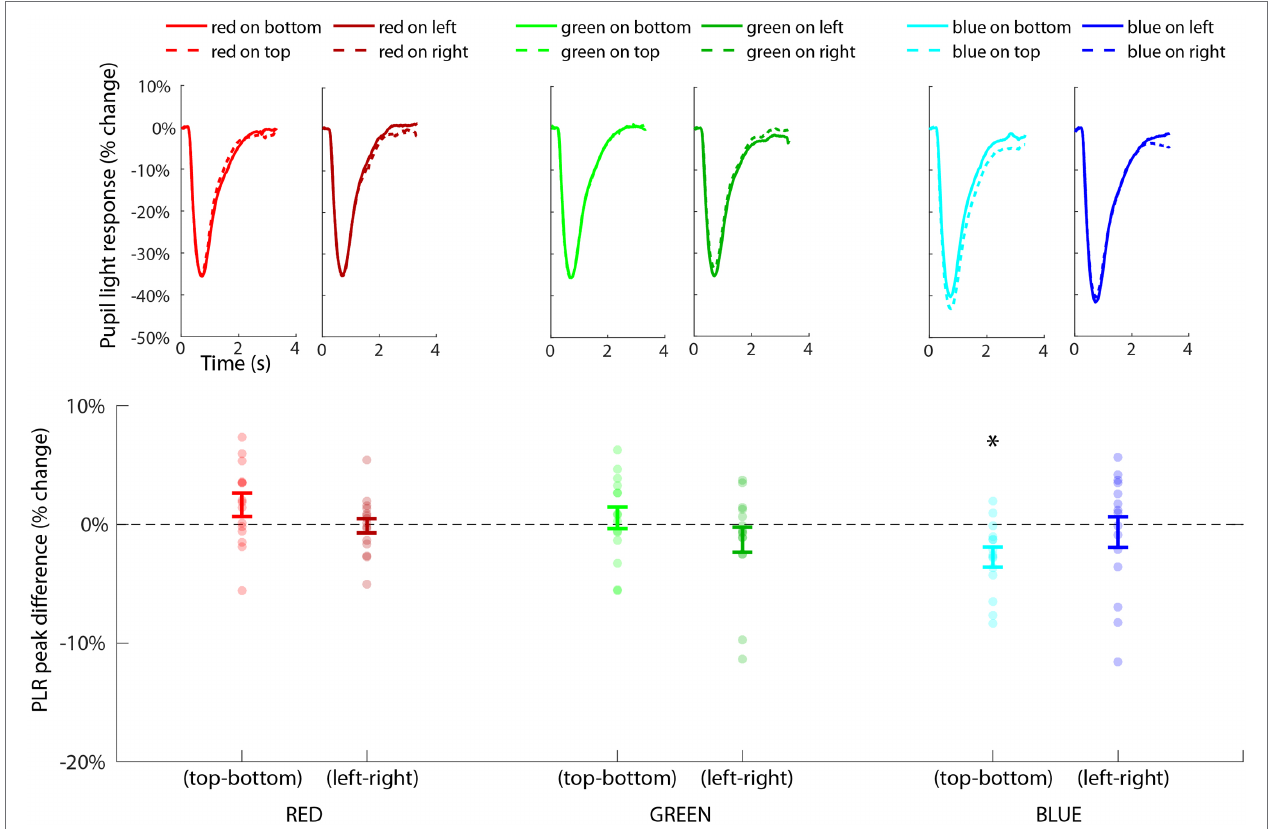
FIGURE 7 | Results of Experiment 2 showing the PLR for each condition (top), organized by color and orientation (i.e., horizontal and vertical) along the x-axis. Statistical tests were conducted on the distribution of PLRmin difference scores (bottom) across subjects (i.e., individual dots) for each planned comparison of each type of color/orientation combination. The only significant effect ( p < 0.02, FDR < 0.05) was the comparison of blue on top minus blue on bottom (indicated with *) showing that blue on top induced a significantly larger PLR than blue on